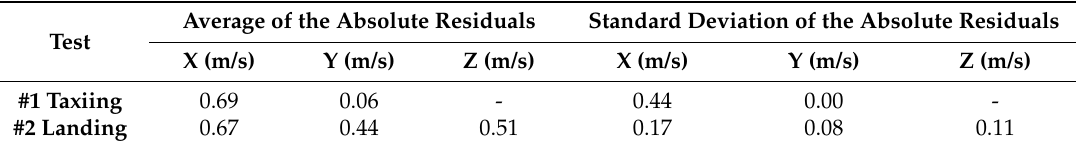
Table 4. Quantitative statistics of the CT